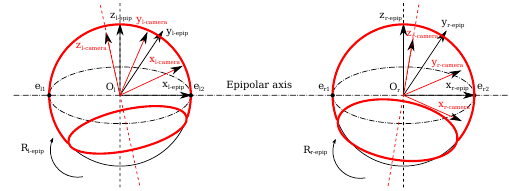
Figure 4: Illustration of epipolar and camera reference frames in both